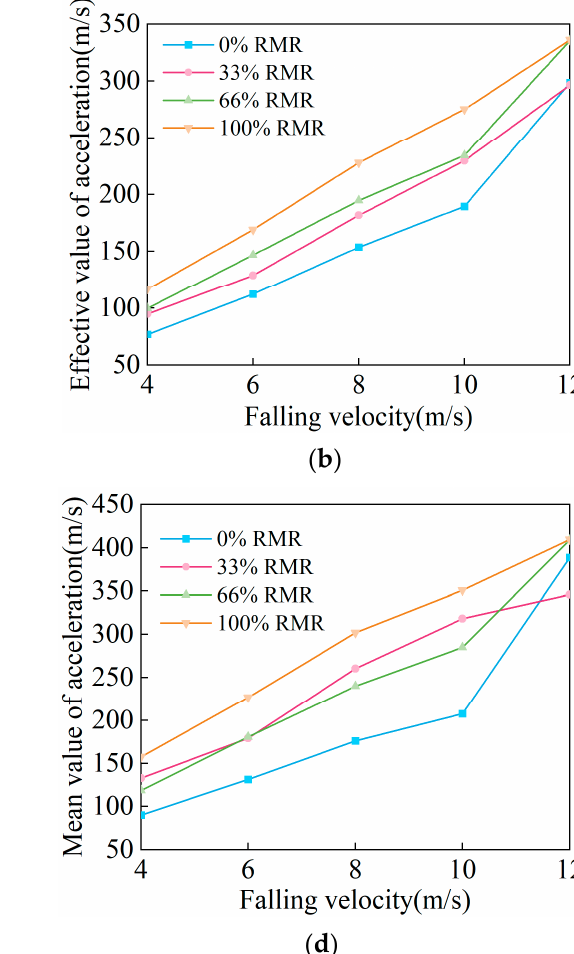
( b ) Figure 9. Vibration signal distribution in different areas on the tail beam. ( a ) Velocity. ( b ) Accelera- tion. 3.1.2. Influence of the Falling Velocity on Vibration Signal In the study of coal gangue identification based on vibration, the geological condi- tions of different mining areas and the change of coal seam thickness are not negligible. The thickness of the coal seam determines the height of coal caving. This section studies how the signal difference caused by different RMR changes under different falling speeds. Keeping the other settings the same as the previous section, the coal gangue particles with four RMRs in the previous section were tested at different speeds, and the falling speeds were set to 4 m s − 1 , 6 m s − 1 , 8 m s − 1 , 10 m s − 1 , and 12 m s − 1 . As shown in Figure 10, due to the inhomogeneity of the surface shape of the coal gangue particles and the number of particles in the calculation not being very large, the influence caused by the change of the contact state of a single particle may be reflected in the overall result. In some calcula- tion cases, the results deviate from the expected law, but on the whole, with the increase of the falling velocity, the average energy and average level of the vibration signal show